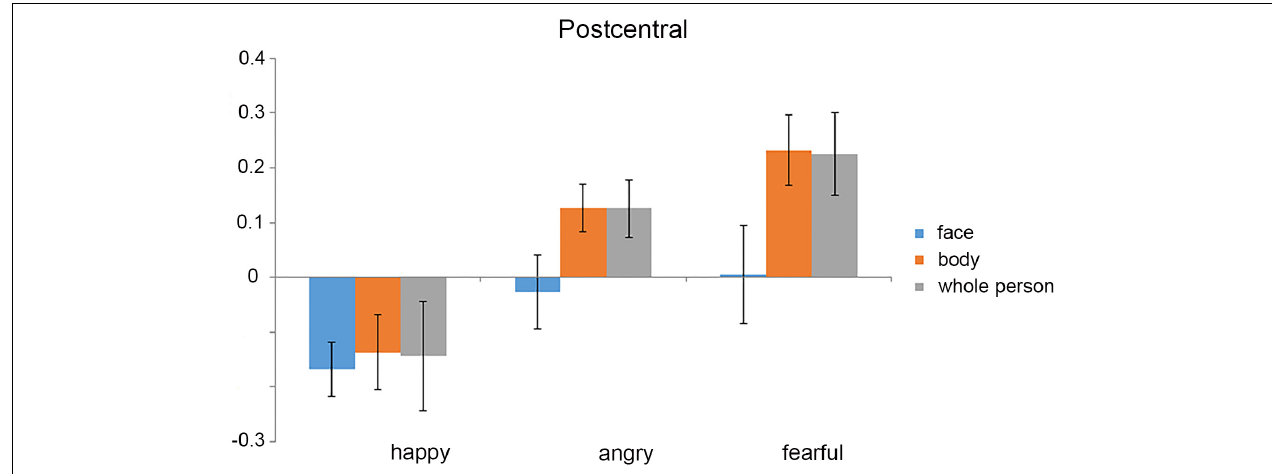
FIGURE 5 | Mean activation (parameter estimates) for each experimental condition in the left postcentral gyrus. The mean activation was extracted from the left postcentral gyrus by averaging the stimulus-related activations [as estimated from the general linear models (GLMs)] across all the voxels. We found that the mean activations in all of the stimulus conditions were below the baseline. Error bars show SEM.